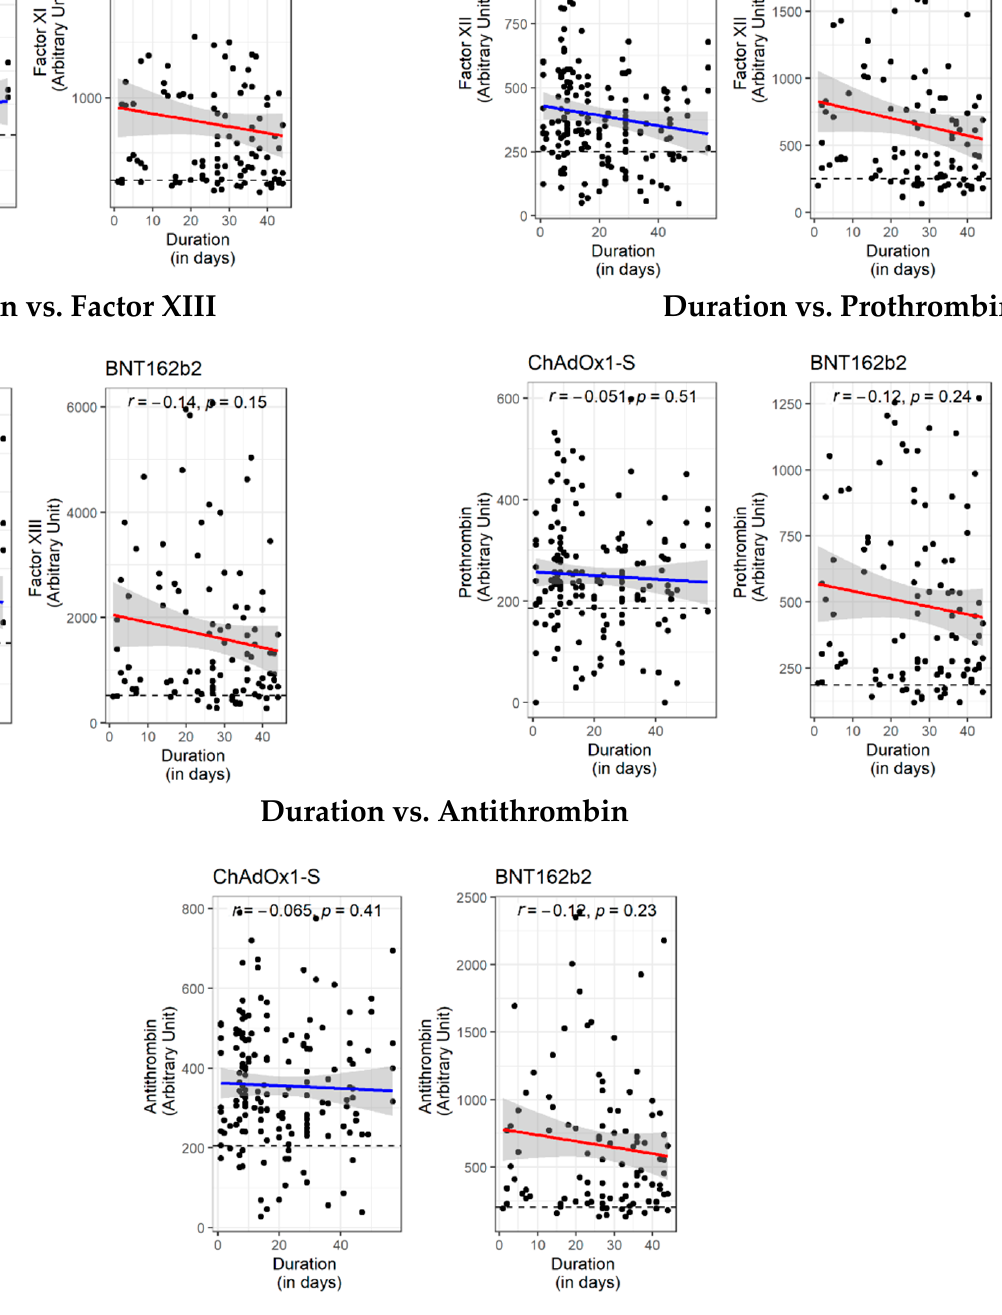
Figure 2. Correlation of circulating levels of coagulation factors/antithrombin with the duration (in days) between the administration of the 2nd dose of either the ChAdOx1-S or BNT162b2 vaccine and sample collection (ChAdOx1-S vaccine: 1–57 days post dose 2 with a median of 16 days (IQR: 8, 29), n = 166; BNT162b2 vaccine: 1–44 days post dose 2 with a median of 27 days (IQR: 18, 36), n = 103). The non-parametric Spearman’s r test was used for correlation analysis.